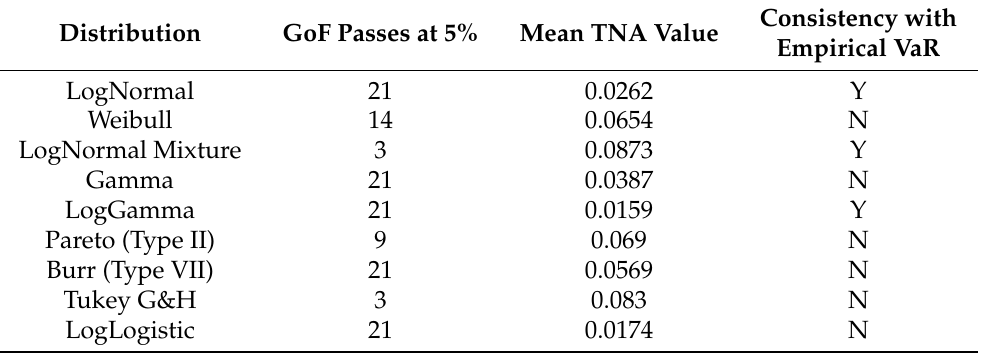
Table 5. Goodness-of-fit for historic nonCPBP data. Column “GoF passes at 5%” shows the number of GoF passes out of 21. Column “Mean TNA value” shows the mean of the corresponding values of the TNA statistic. “N”/“Y” in column “Consistency with Empirical VaR” means that the calculated VaR is inconsistent/consistent with the empirical